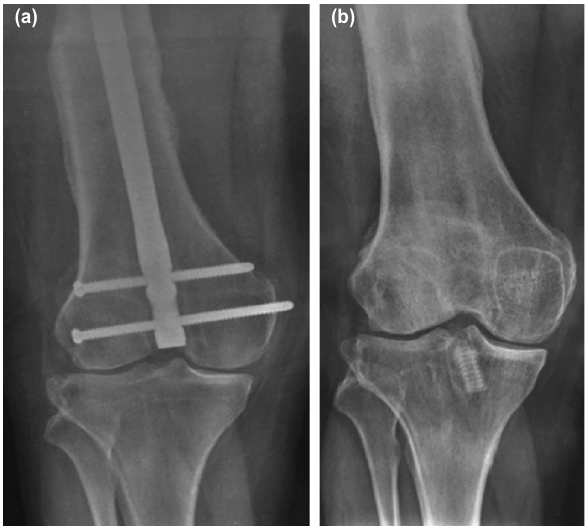
(a) Pre-operative showing the retrograde femoral nail Fig. 1: and healed femoral fracture. (b) Post-operative following ACL reconstruction and Modified LeMaire.